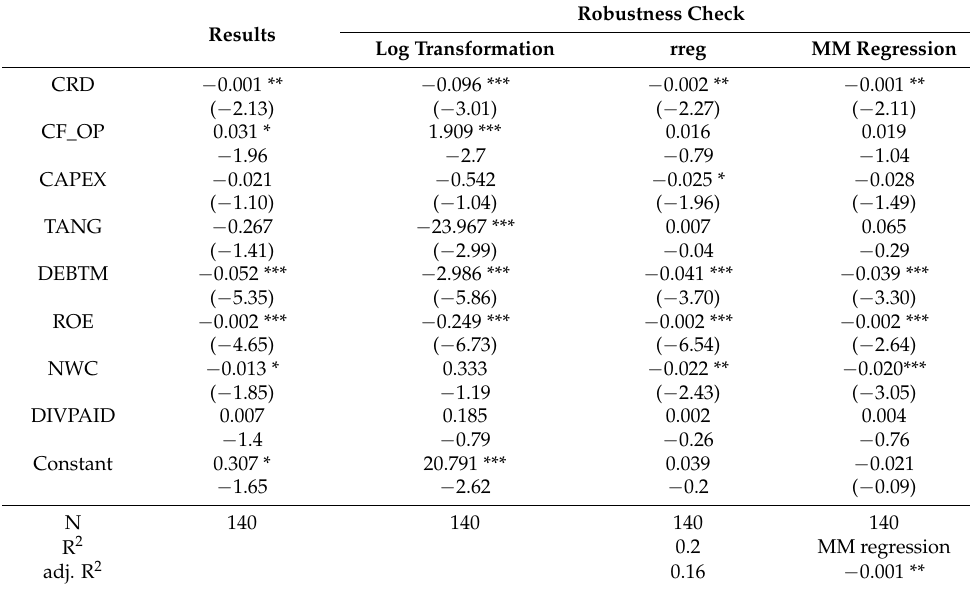
Table 8. Robustness